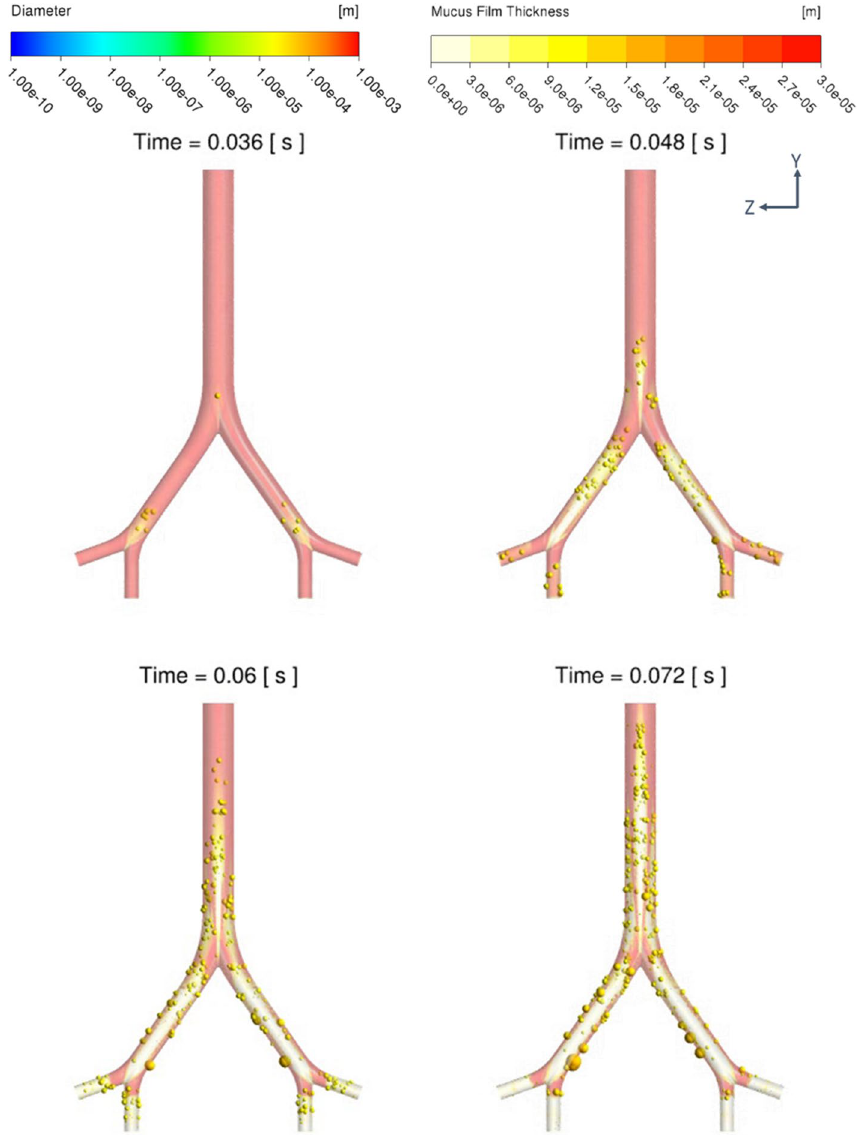
Figure 6. Generated droplets and thickness of the mucous film over time at CPFR = 4